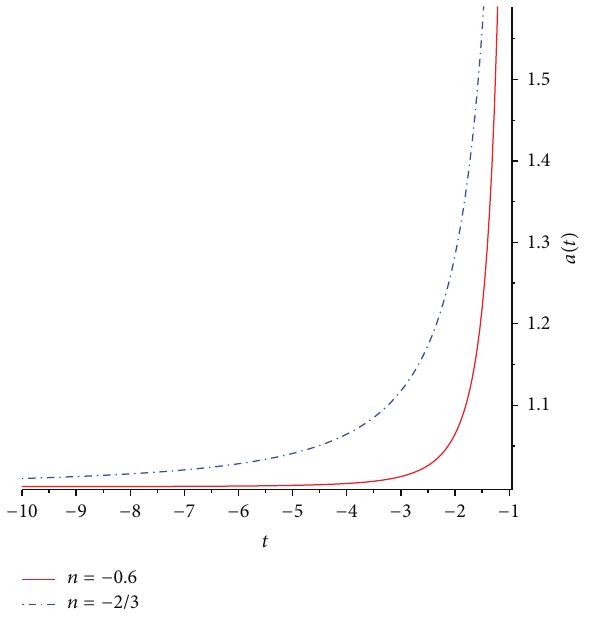
Figure 3: The Figure shows the graphical representation of the scale factor 𝑎(𝑡) against 𝑡 for 𝐴 = −1